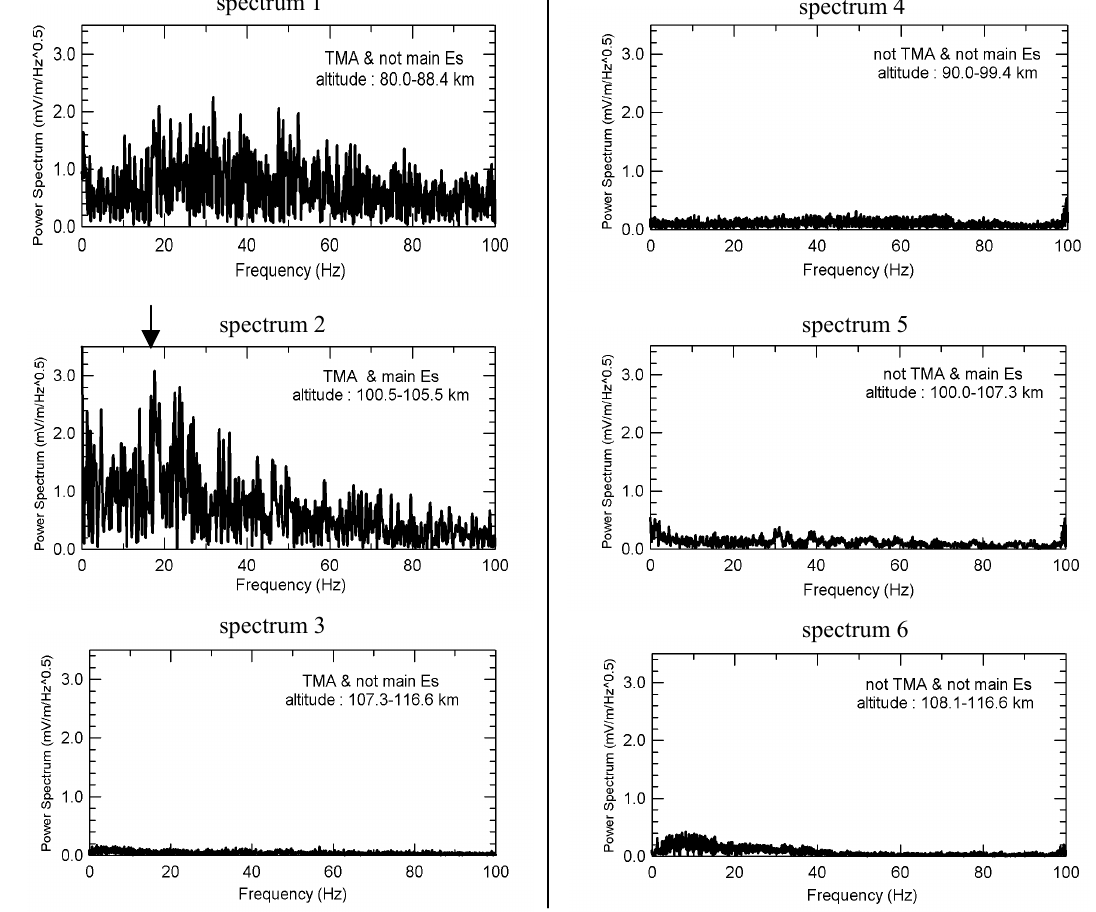
Fig. 7. The plasma wave spectrum obtained by using PWM1 (ascending phase). Left (spectra 1–3) and right (spectra 4–6) panels represent the spectrum of TMA ON and OFF in each altitude range, respectively. Characteristic peak at 17.6Hz is represented by arrow. All enhanced waves are due to the TMA ON. The waves were weakened above the main E s layer, even in the TMA ON period.